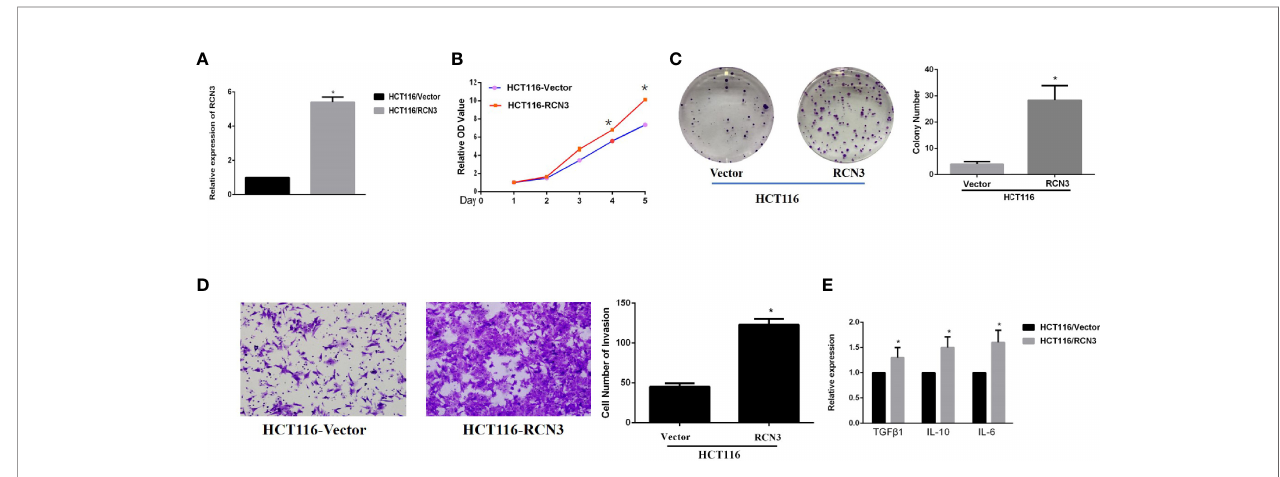
FIGURE 9 | Fold change of expression level of RCN3 ’ s RNA expression after transfection in HCT-116 was shown (A) . Over-expression of RCN3 signi fi cantly promotes the proliferation and invasion ability in CRC cells (B-D) and promotes the expression of immune related factor, including TGF b 1, IL-10, and IL-6 (E) . *p <